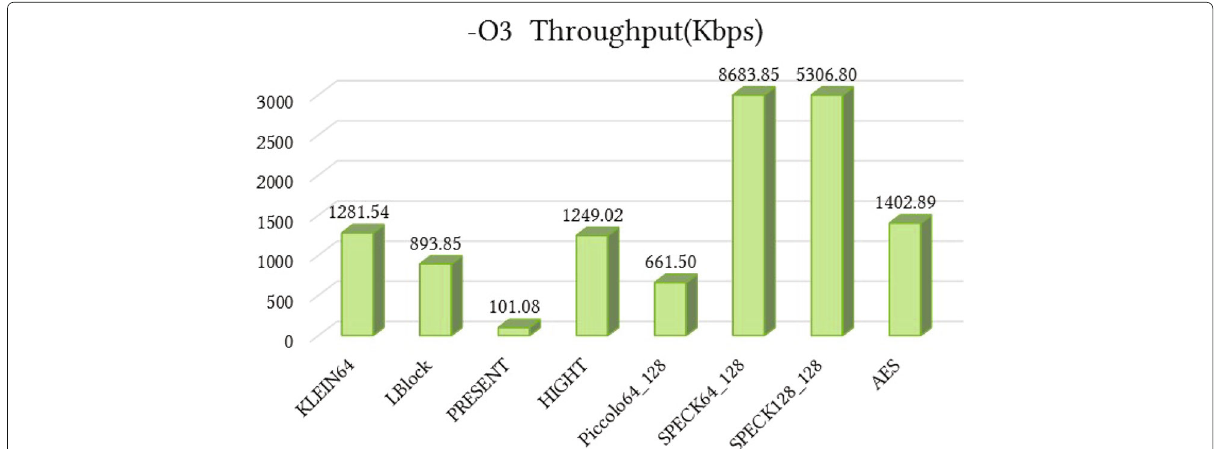
Fig. 12 Throughput in the mode